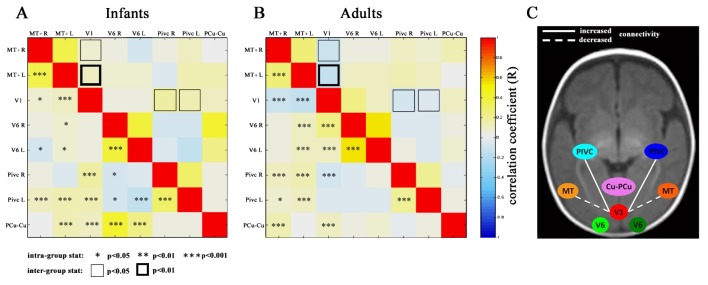
BOLD resting state network.A and B: Correlation matrices of the BOLD resting state activities between all possible ROIs in infants (left) and adults (right). Each value (see scale) shows the average of the correlation across subjects. The significance of each value is indicated by the stars in the checks below the main diagonal, showing the p-values obtained by the cross-correlation calculated concatenating the normalized resting state BOLD signals of all subjects of the group. To test for differences between infant and adult correlation matrices, a two-tailed t-test was performed between the two groups, and the checks with contour above the main diagonal indicate the two significantly (at p < 0.01 and p < 0.05) different values. C: The diagram illustrates the two correlations that are different between adult and infants. The weak connectivity in infants between V1 and temporal-occipital areas was also observed in [46,48]. (V1: primary visual cortex seed; MT+: temporo-occipital complex; V6: Visual area six on medial-parieto-occipital region; PIVC: posterior insular vestibular cortex; PCu/Cu: Pre-Cuneus/Cuneus; R: right; L: left.) Numerical data are available in the supporting file “S1 Data“, Fig 5.